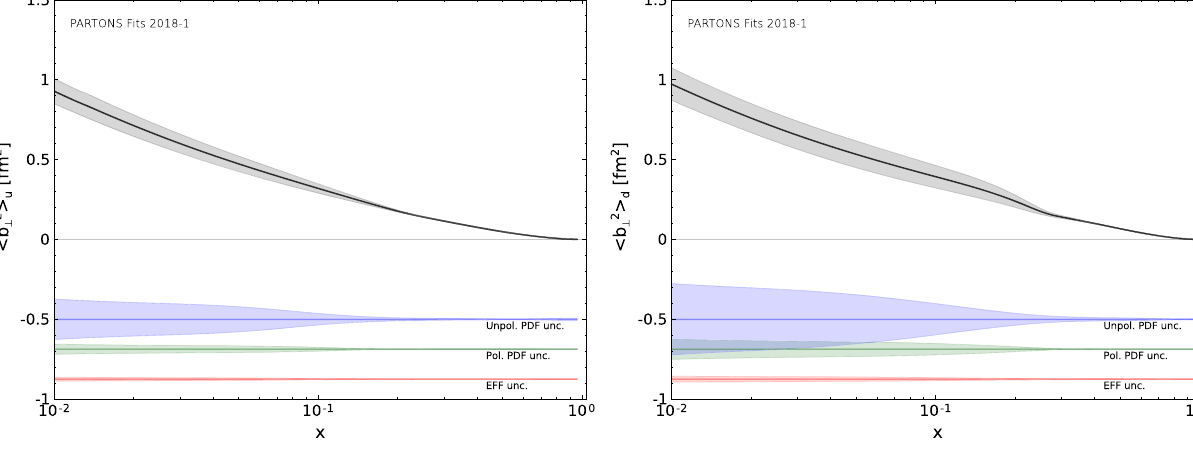
Fig. 16 Normalized second moment of the q ( x , b ⊥ ) distribution for up (left) and down (right) quarks as a function of the longitudinal momentum fraction x . For further description see Fig.